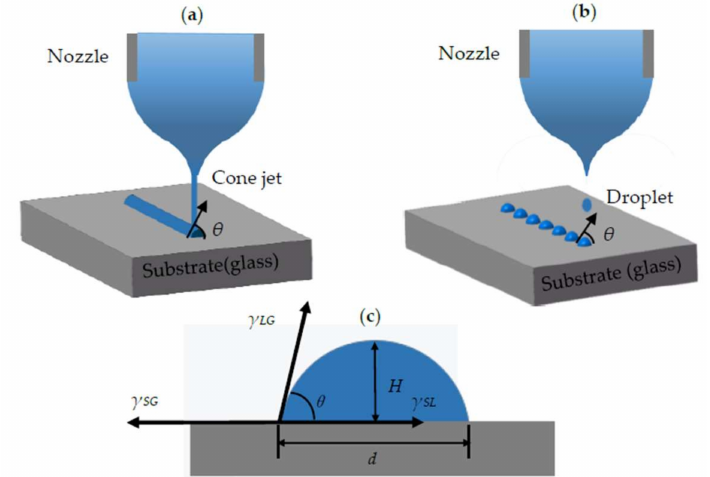
Figure 8. Schematic diagram of droplet deposition: ( a ) high-viscosity material deposition on the glass substrate; ( b ) low-viscosity material deposition on the glass substrate; ( c ) model of the contact angle on the